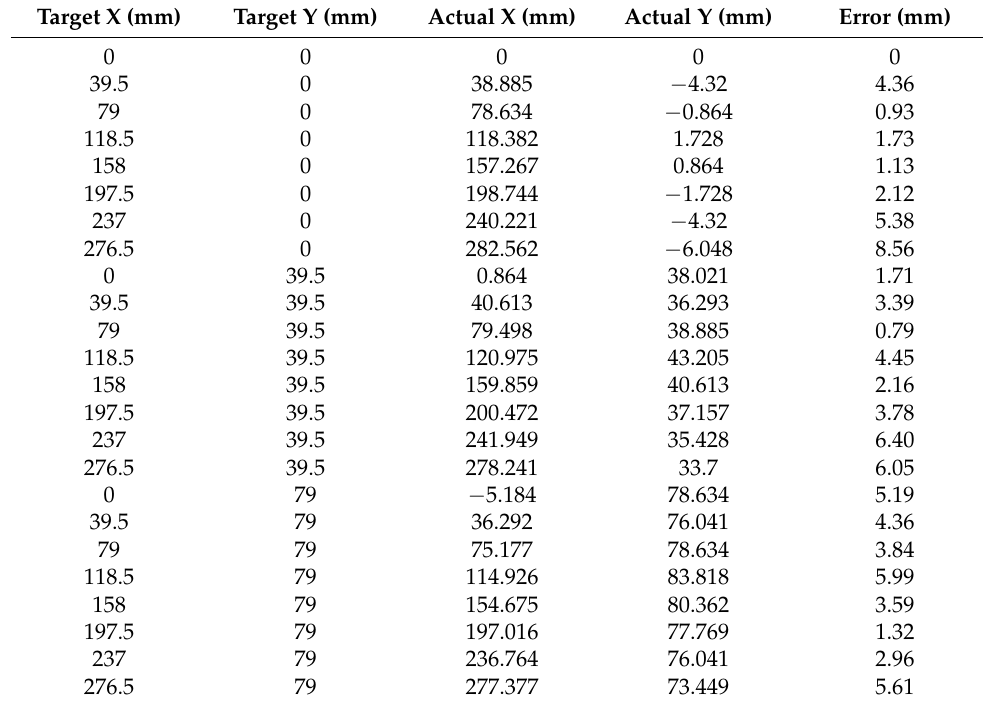
Table A1. Run 1 positional data (lower half of the